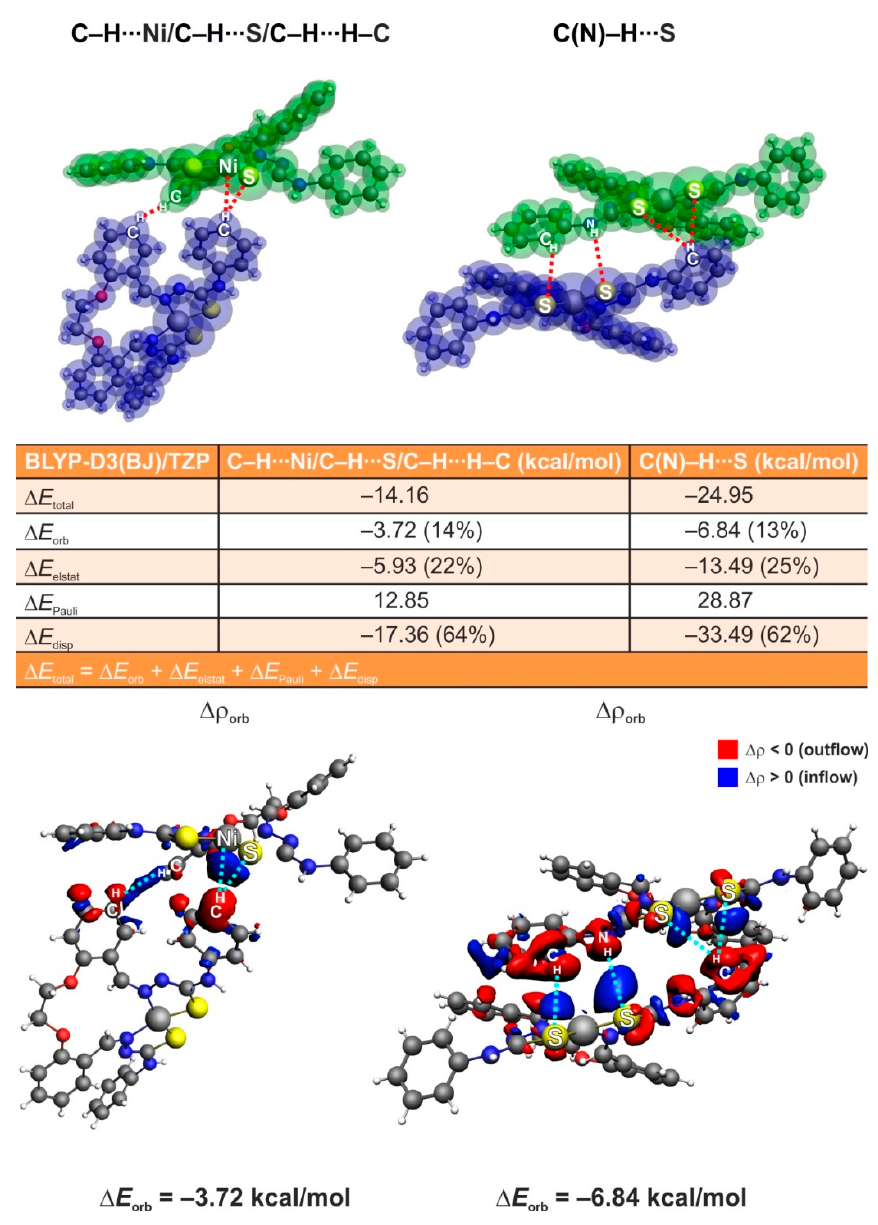
Figure 10. The results of ETS-NOCV energy decomposition describing C–H ∙∙∙ Ni, C–H ∙∙∙ S and C–H ∙∙∙ H–C (left), and C–H ∙∙∙ S and N–H ∙∙∙ S (right) interactions in 1 . Additionally, the overall deformation density Δρ orb with the corresponding Δ E orb are presented.